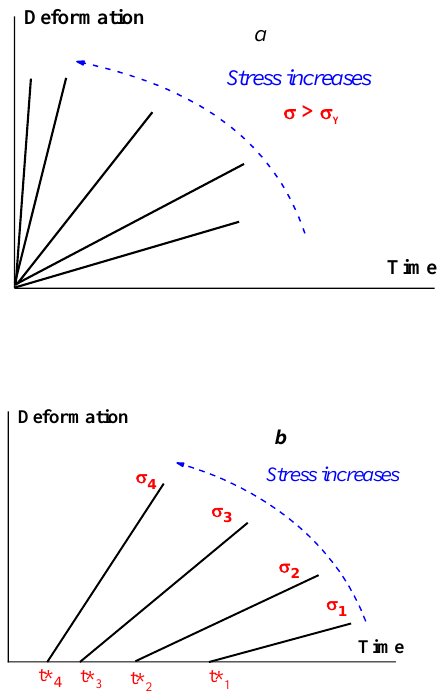
Figure 9. Yielding: leading to instantaneous solid-to-liquid transition at σ > σ Y ( a ) and durability as the dependence of the start of deformation on stress, t ∗ ( σ ) ( b ).